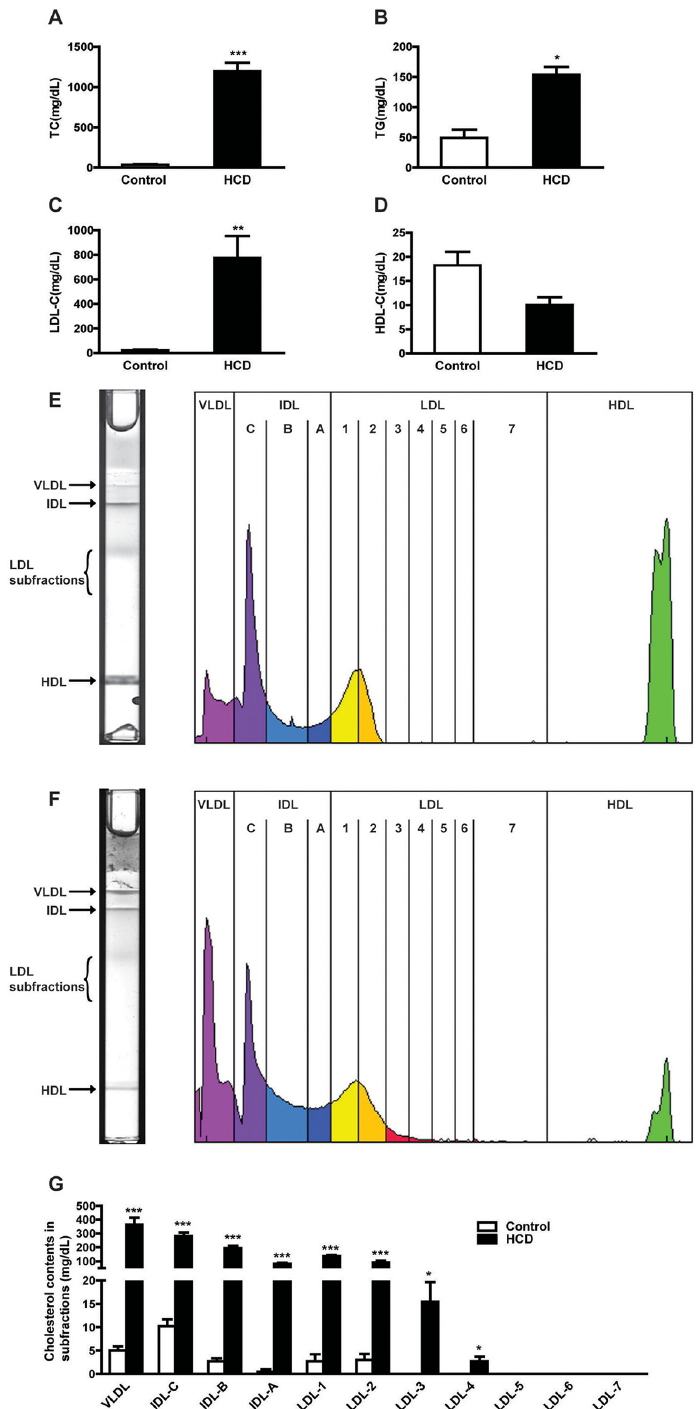
Fig 4. Plasma lipids and lipoprotein profiles of chow diet and high cholesterol-fed rabbits. Total cholesterol (TC) (A), triglyceride (TG) (B), low density lipoprotein-cholesterol (LDL-C) (C), and high density lipoprotein-cholesterol HDL-C (D) were measured. Representative image of LDL in polyacrylamide tube gel electrophoresis and the corresponding scanned and computerized lipoprotein profile in plasma of controls (E) and hypercholesterolemic rabbits (F). ApoB-containing particle subfractions were quantified in plasma of controls and hypercholesterolemic rabbits (G). Data are expressed as the mean ± SEM. n = 4 or 5 for each group. * P < 0.05 ** P < 0.01, *** P < 0.001. HCD, high cholesterol diet.